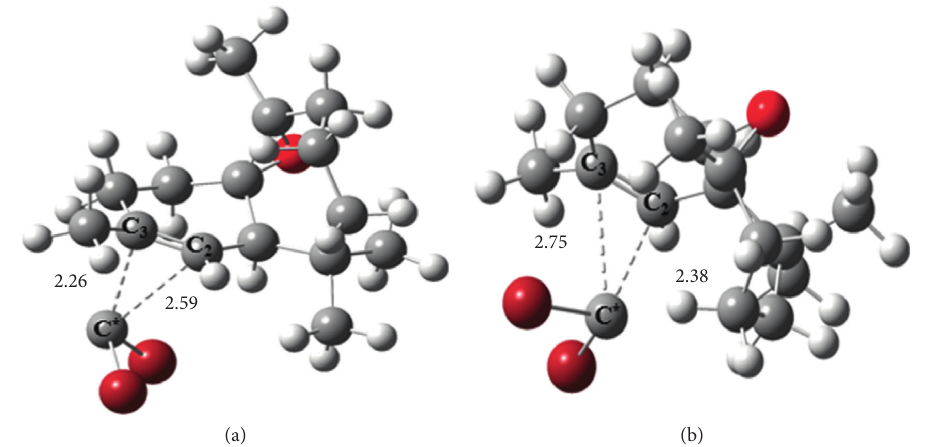
Figure 7: Bond lengths (˚A) of the transition states of the reaction between P